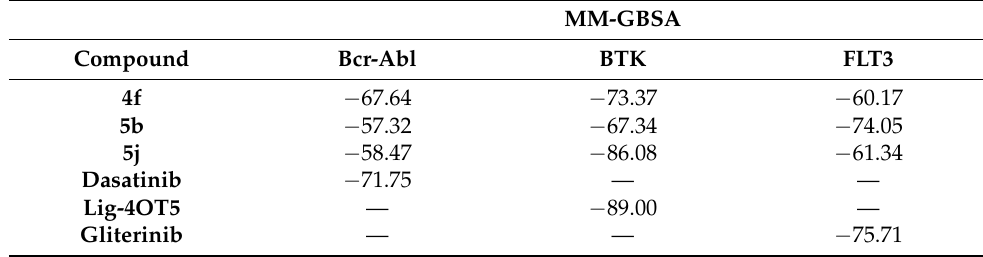
Table 2. Binding affinity scores (kcal/mol) for selected purines in the enzyme active sites. MM-GBSA Compound Bcr-Abl BTK FLT3 4f − 67.64 − 73.37 − 60.17 5b − 57.32 − 67.34 − 74.05 5j − 58.47 − 86.08 − 61.34 Dasatinib − 71.75 — — Lig-4OT5 — − 89.00 — Gliterinib — — −